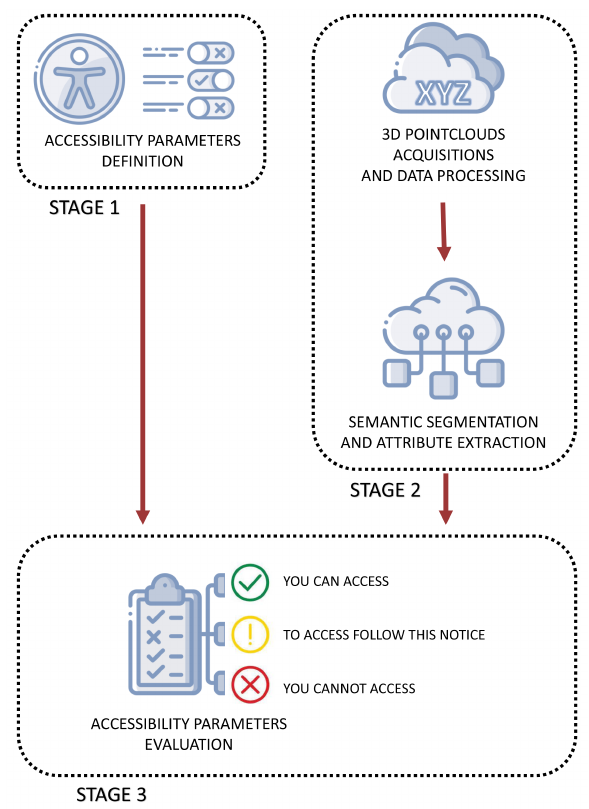
Figure 1. The main workflow of the proposed project, composed by 3 stages: the delineation of accessibility parameters, the 3D data acquisition and segmentation, the evaluation of accessibility through parameters assess. Stage 1 is the main topic of this paper.